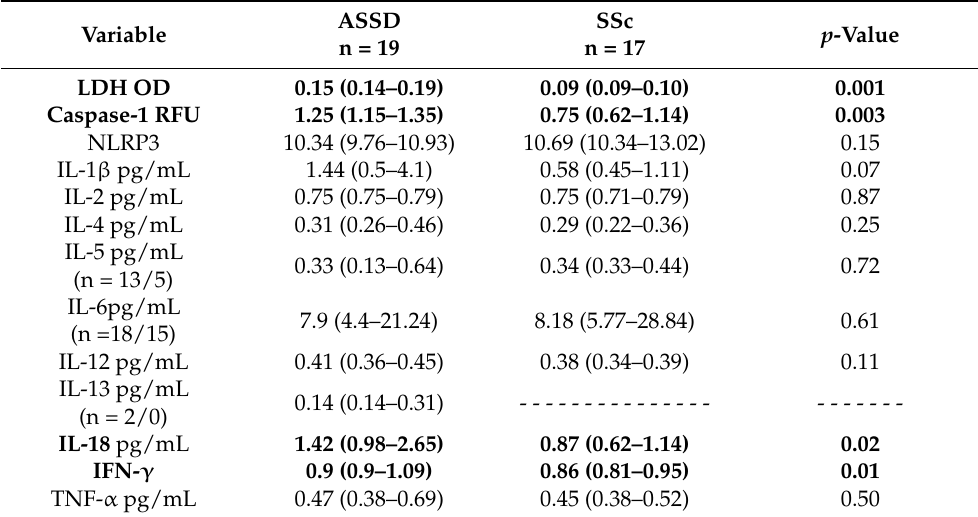
Figure 1. Comparison of molecules related to inflammasome activation quantified in BAL between patients with the anti-synthetase syndrome (ASSD) and systemic sclerosis (SSc). The cellularity was determined by counting with a Neubauer hemocytometer ( A , B ); quantifying cytokine concentration in BAL was performed by commercial ProcartaPlex system ( C , D ); the caspase-1 activity was quan- tified by fluorometry ( E ). Finally, the concentration of LDH and NLRP3 was quantified by ELISA ( F , G ). Comparisons between groups were made using the Mann–Whitney U test, and the results of the statistical inference were confirmed with the Hodges–Lehmann test. Table 3. Comparison of cytokines and proteins values of the inflammasome